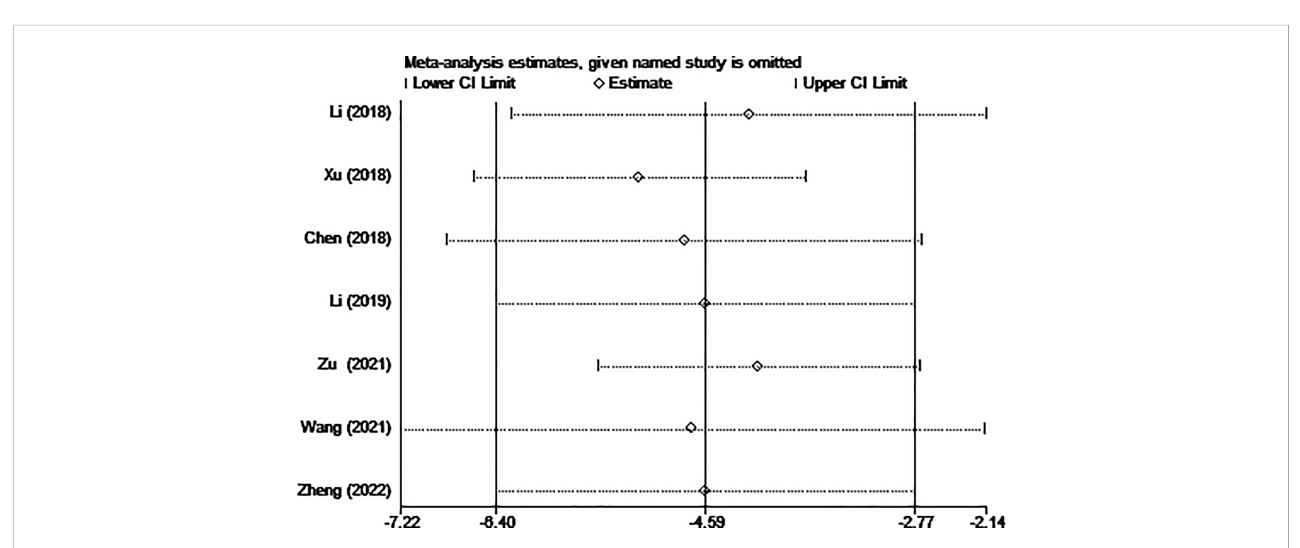
FIGURE 13 Sensitivity analysis of hospital stay for comparing MWA with surgery in patient with PTMC. MWA, microwave ablation, PTMC, papillary thyroid